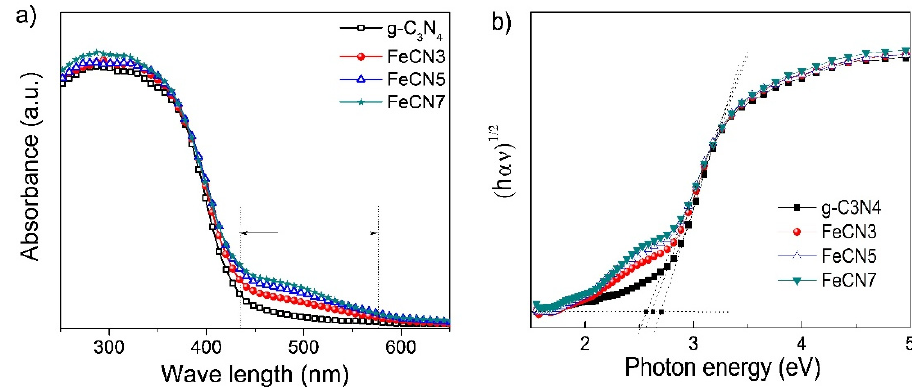
Figure 6. ( a ) Absorption spectra of Fe-doped g-C 3 N 4 nanosheets with different Fe concentrations and ( b ) Wood-Tauc method in determining the band gap energy of indirect semiconductor.